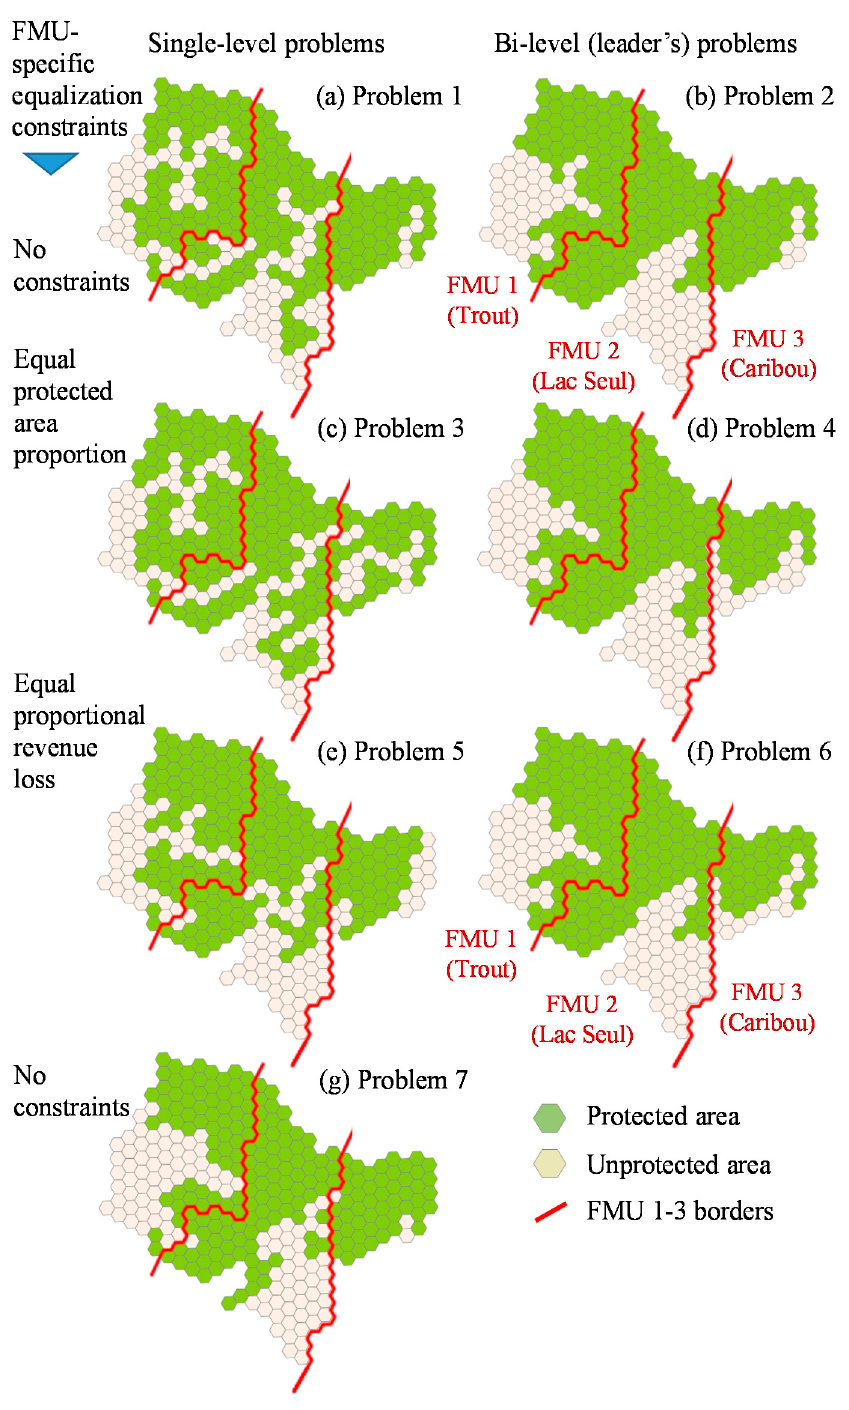
Figure 5. Habitat protection patterns in problem 1–7 solutions, S = 0.65.